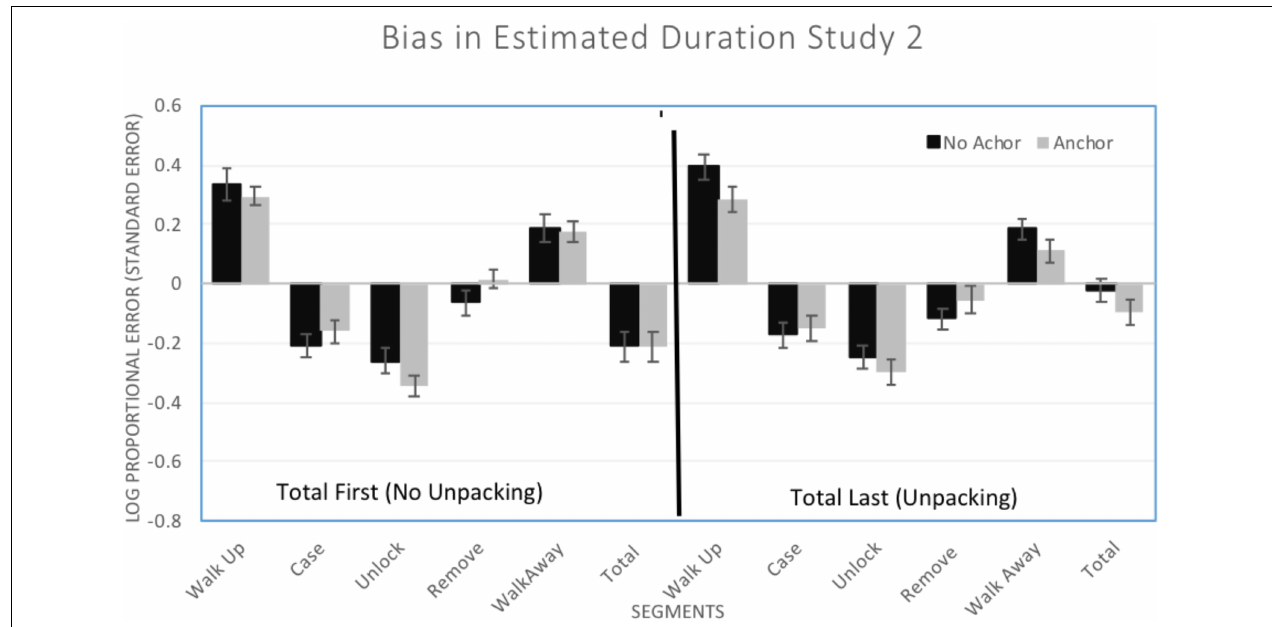
FIGURE 3 | Mean ( ± 1 SE ) bias in estimated duration (log of estimated duration/actual duration) for all of the segments of the crime. Positive values indicate overestimation and negative values indicate underestimation.